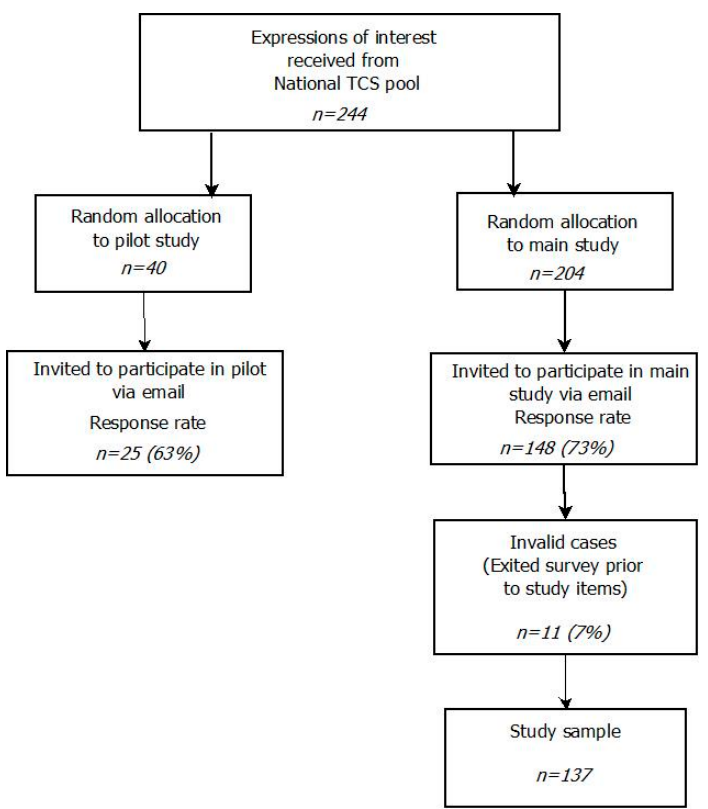
Figure 1. Participant recruitment flow chart.